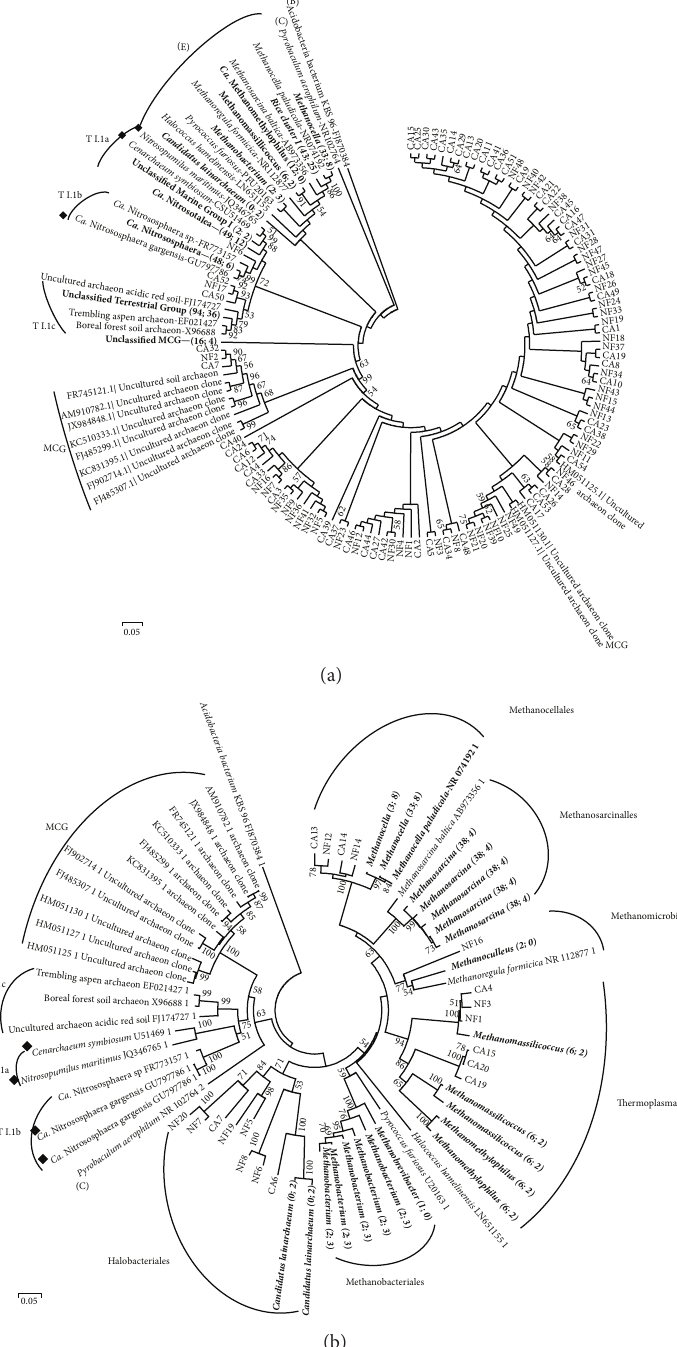
Figure 5: Phylogenetic trees of (a) unclassified Thaumarchaeota 16S rRNA gene sequences from native forest soil and soil under oil palm cultivation and (b) 16S rRNA gene sequences classified as Euryarchaeota from native forest soil and soil under oil palm cultivation. The neighbor-joining method and Jukes-Cantor corrections were used with 1,000 bootstrap replicates. Bootstrap values above 50 are shown in the trees. A representative number of operational taxonomic units (OTUs) were selected at 3% dissimilarity by MOTHUR to avoid redundancies in the phylogenetic trees. Randomly chosen OTUs from native forest soil and from soil under oil palm cultivation were used in the construction of the trees, along with archaeal reference sequences (from GenBank) from the following groups: Acidobacteria